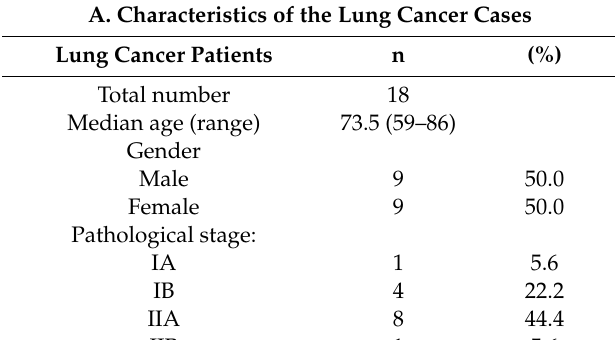
Table 1. Characteristics of lung cancer and non-cancerous cases.